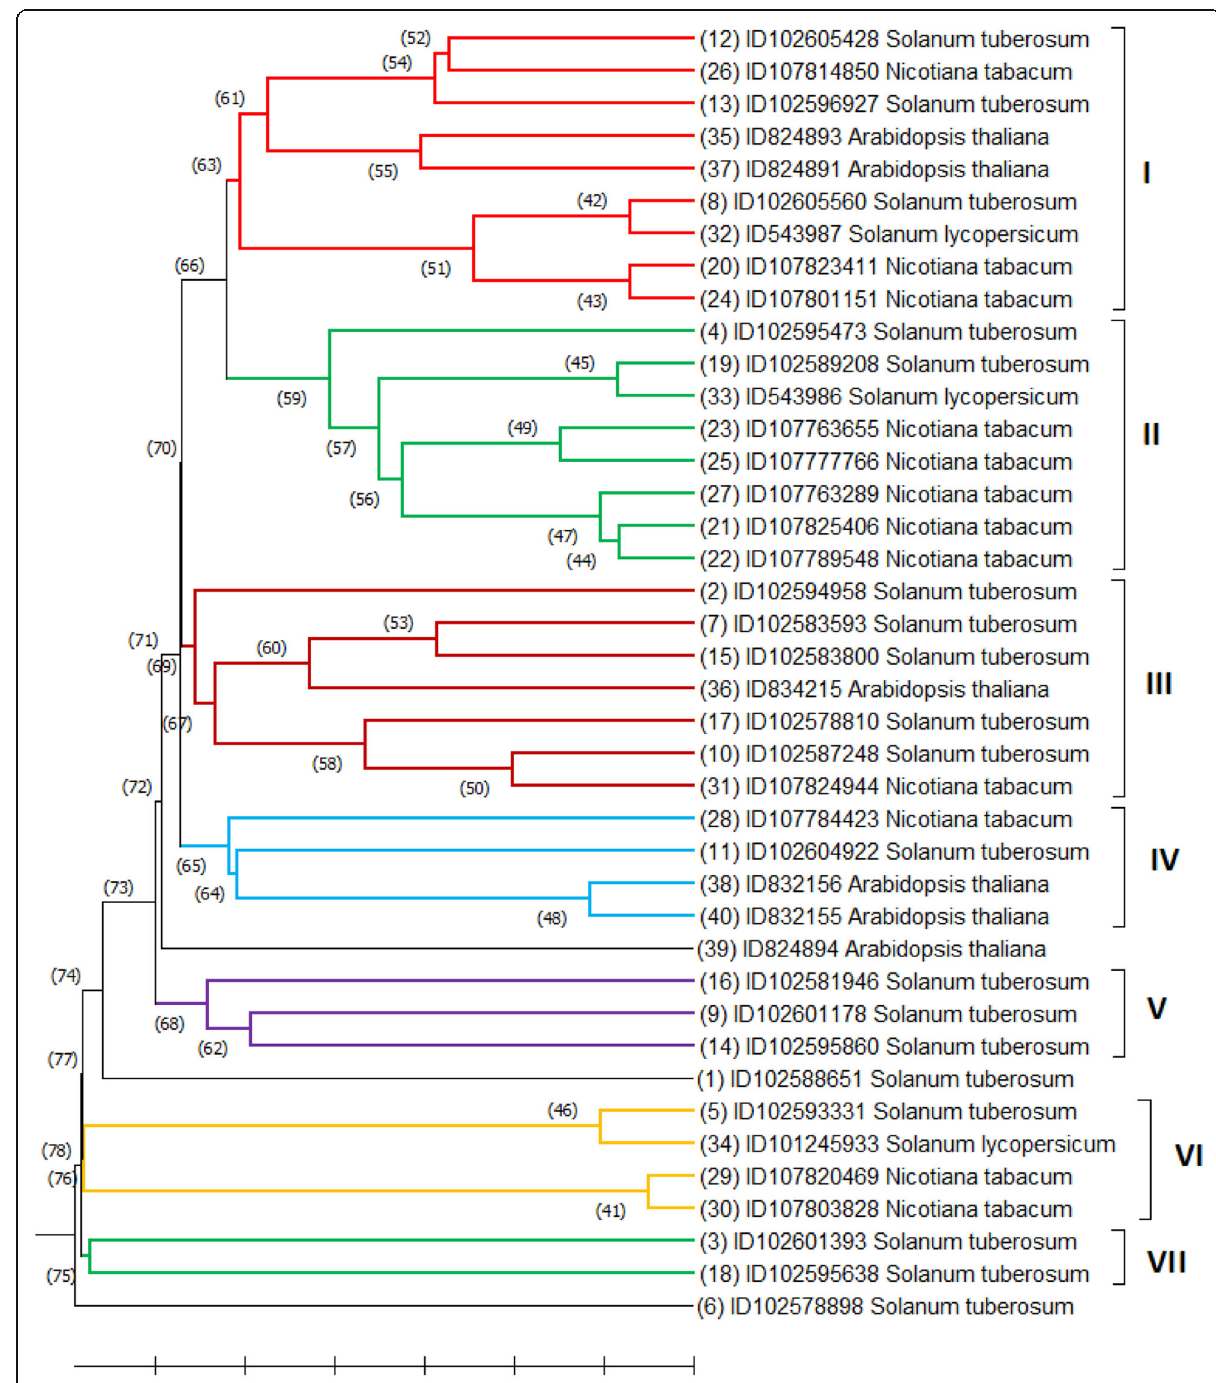
Fig. 3 UPGMA phenogram illustrating the relationships among the glucan endo-1,3-beta-glucosidase gene sequences grouped by gene ID and scientific